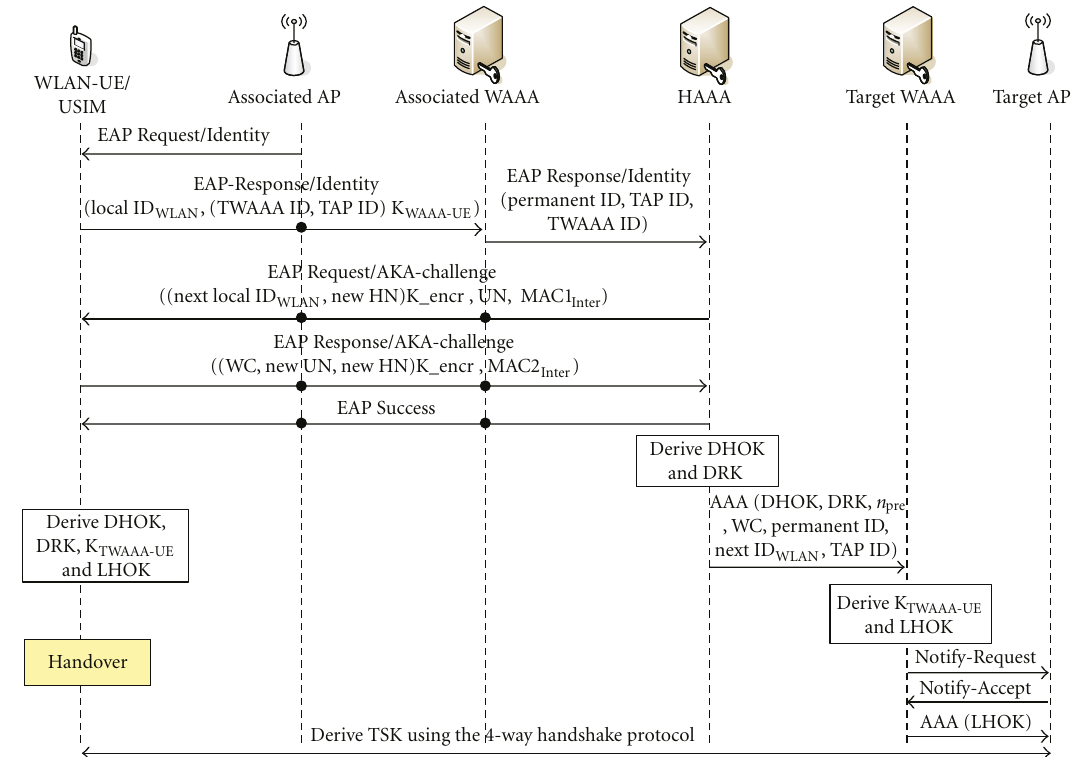
Figure 5: Inter-WLAN fast pre-authentication